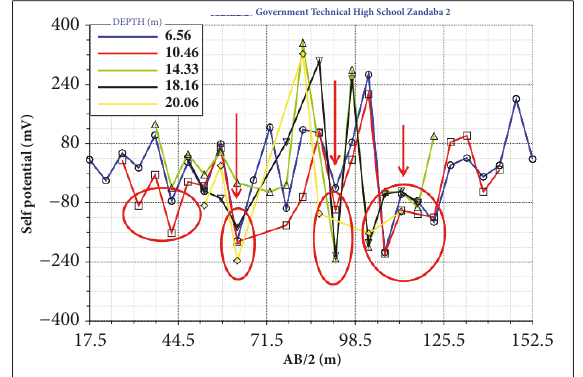
Figure15:PlotsofSPvaluesagainstHalfElectrodesSpacing (AB/2).